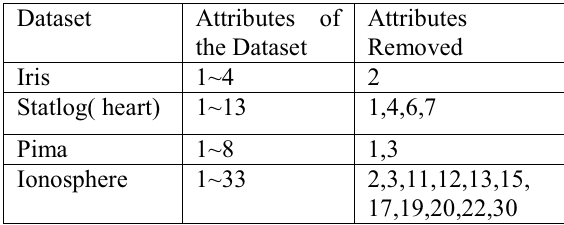
Table 7: Filtered Attributes of Datasets